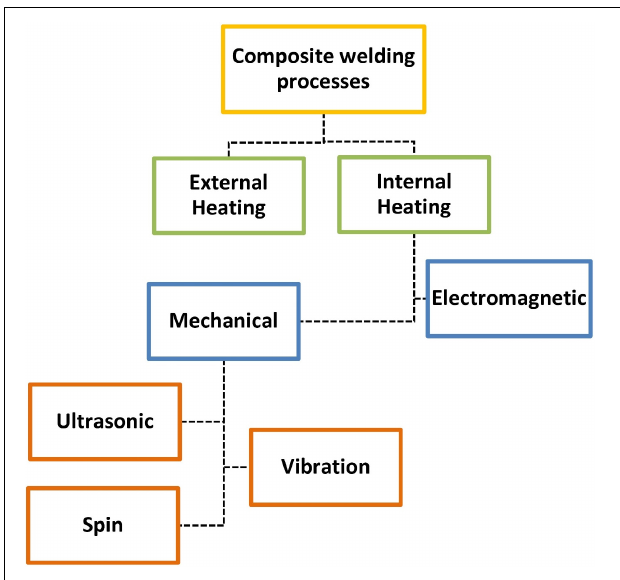
FIGURE 4 | Manufacturing process, classification of welding process used for joining